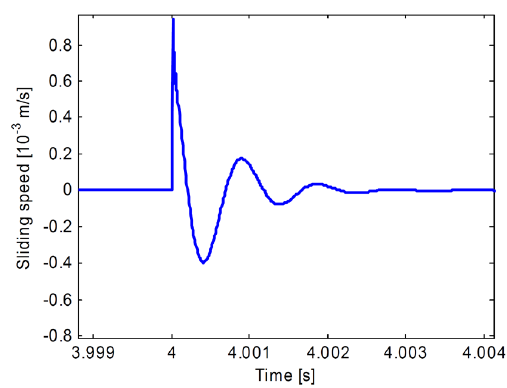
Figure 24. Sliding speed predicted using the elastoplastic model.